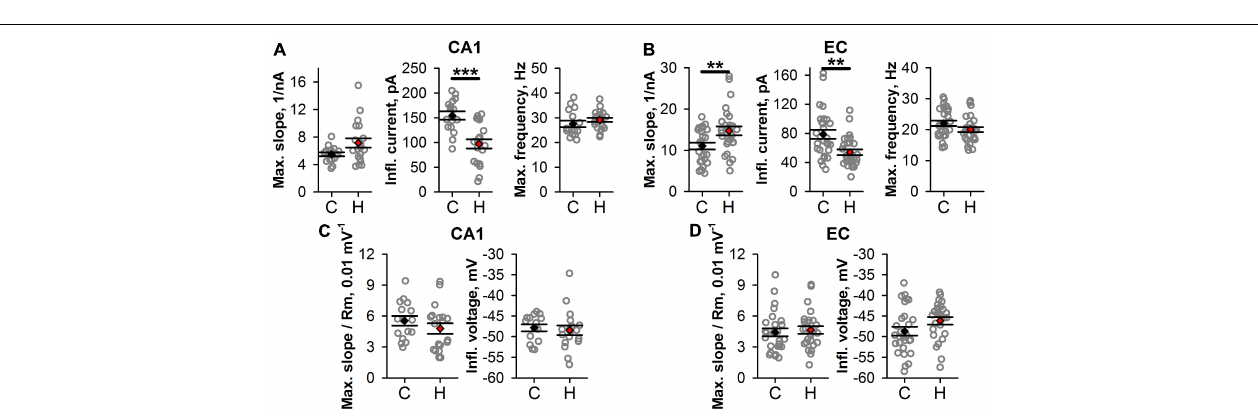
FIGURE 6 | Changes in firing properties of CA1 and EC neurons after prenatal hypoxia. (A,B) The graphs show average values of the parameters of f/I curves in CA1 (A) and EC (B) . (C,D) The graphs show the average parameters of the normalized f/I curves. No significant differences between groups are observed after normalization. Asterisks indicate a significant difference between groups according to an appropriate statistical test. ** P < 0.01, *** P <